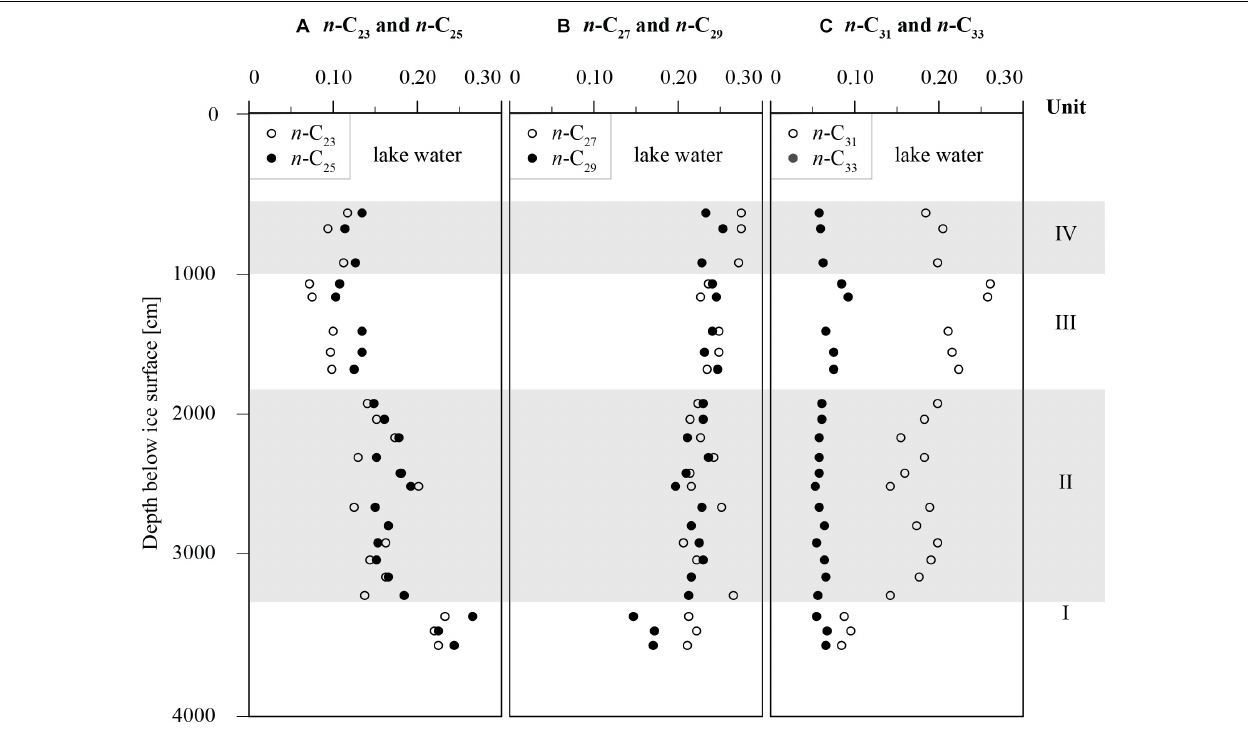
FIGURE 6 | Relative concentration of odd chain n -alkanes of Goltsovoye Lake sediment core PG2412. (A) n- C 23 (open circles) and n -C 25 (closed circles), (B) n -C 27 (open circles) and n -C 29 (closed circles) and (C) n -C 31 (open circles) and n -C 33 (closed circles). Example of formula for n -C 23 : n -C 23 /( n -C 23 + n -C 25 + n -C 27 + n -C 29 + n -C 31 + n -C 33 ). Units indicated on the